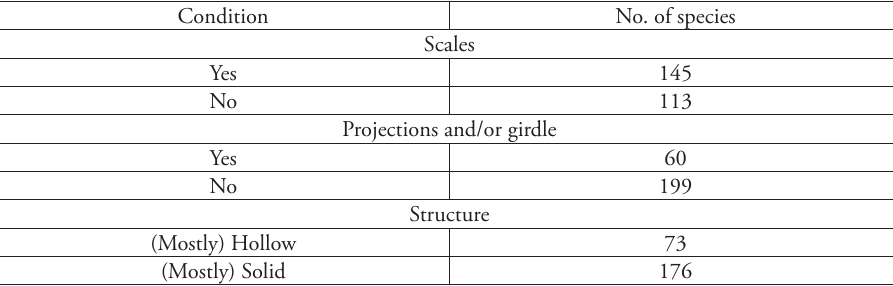
Table 3. Number of species displaying different sphragis